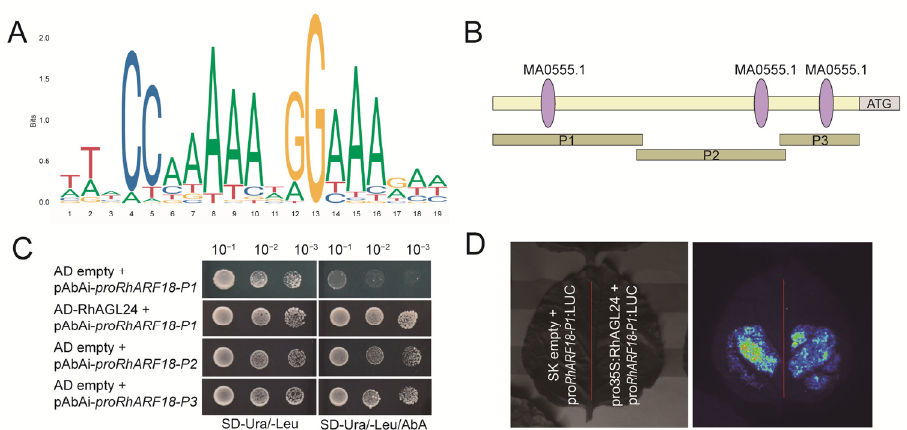
Figure 5. Validation of RhAGL24 downstream genes. ( A ) Prediction of RhAGL24 identifiable se- quences. ( B ) Sequence analysis of RhARF18 promoter. The RhARF18 promoter was divided into three segments of P1, P2, and P3, with one predicted cis -acting element each. MA0555.1 is the cis -acting element of RhAGL24 in (A). ( C ) Yeast one-hybridization between RhAGL24 and RhARF18 promoter; 10 − 1 , 10 − 2 , and 10 − 3 are the concentrations of diluted yeast. ( D ) Dual luciferase assay of RhAGL24 and RhARF18 promoter. The proRhARF18:LUC construct was co-infiltrated with pro35S:RhAGL24 or SK empty vector into N. benthamiana leaves. The picture on the left shows the tobacco in the open field, and the picture on the right shows the tobacco in the fluorescent field.